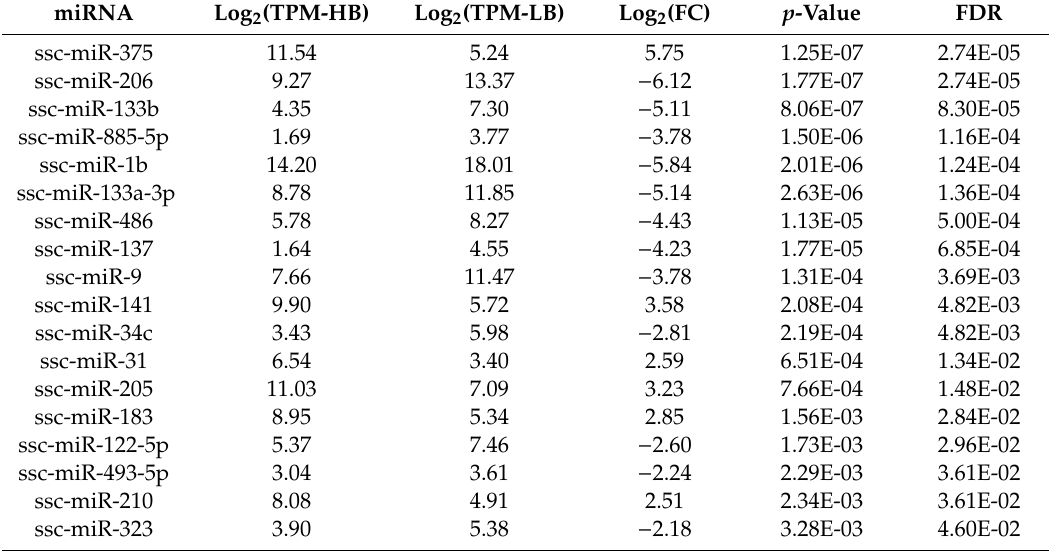
Table 1. The 18 differentially expressed miRNAs detected in Landrace pigs with low and high backfat phenotypes.